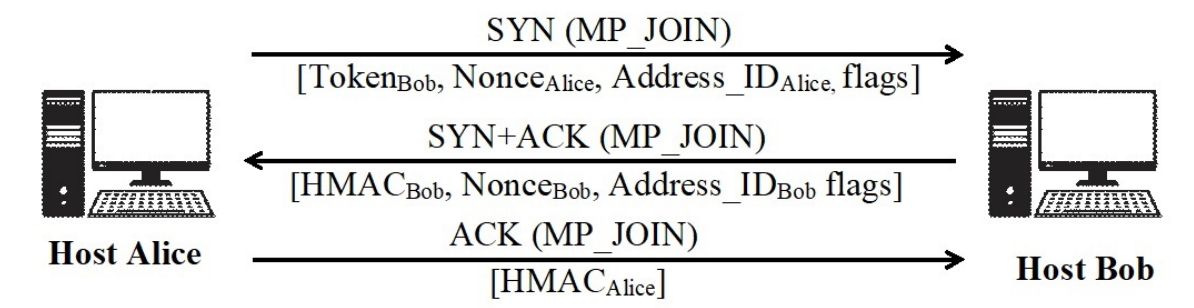
Figure 4. MPTCP Options in Version (v0) adding new subflow using MP_JOIN.